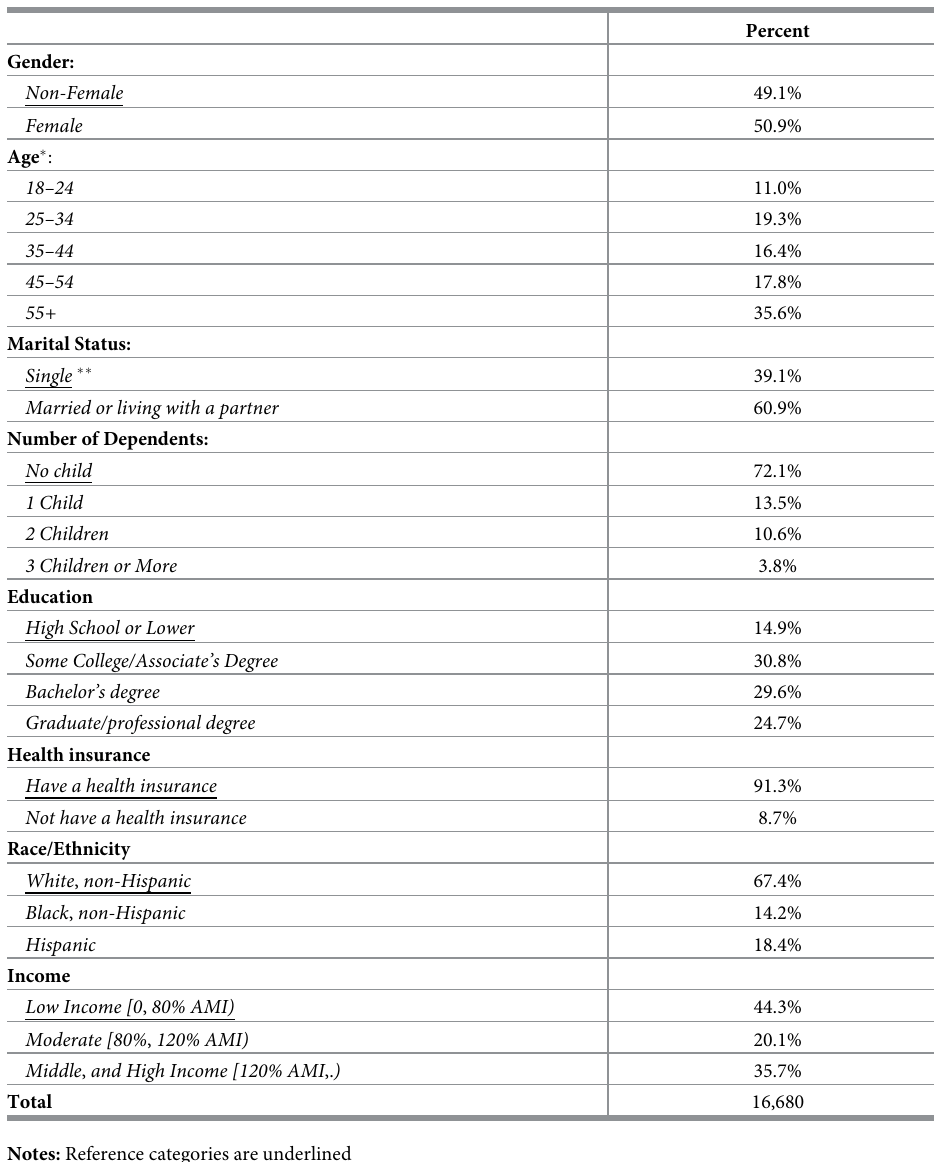
Table 2. Analytic sample